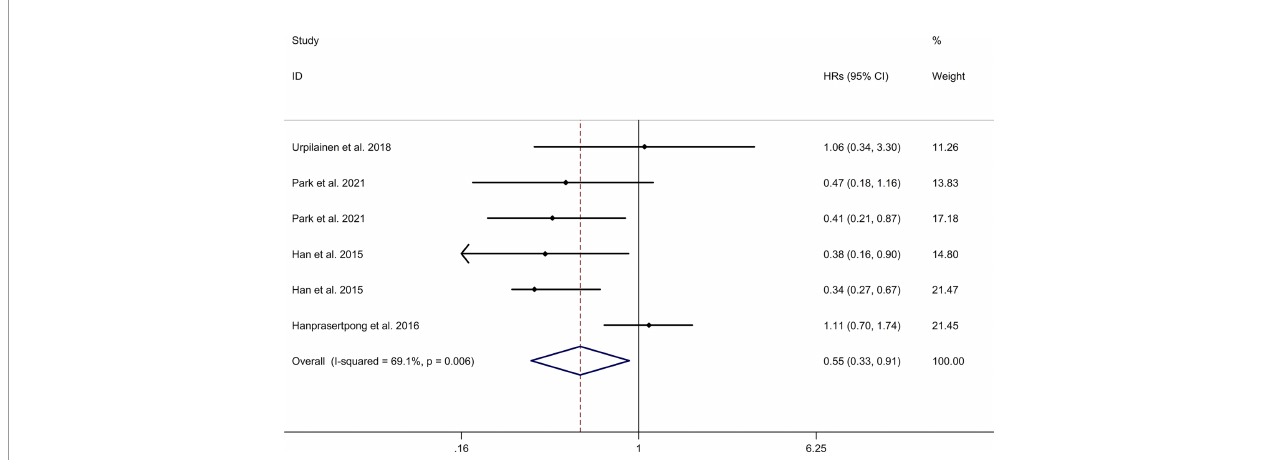
FIGURE 4 | Forest plots of association between metformin use and progression-free survival of gynecologic cancer.